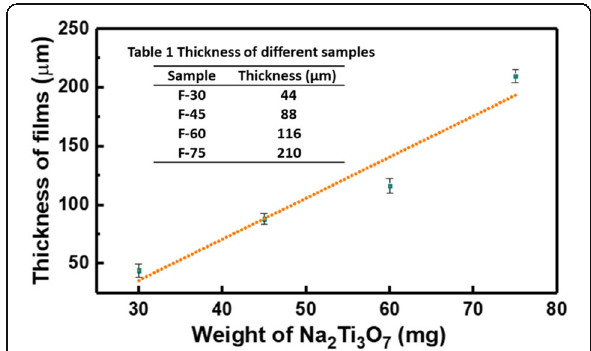
Fig. 4 The plot of thickness versus the weight of the membrane